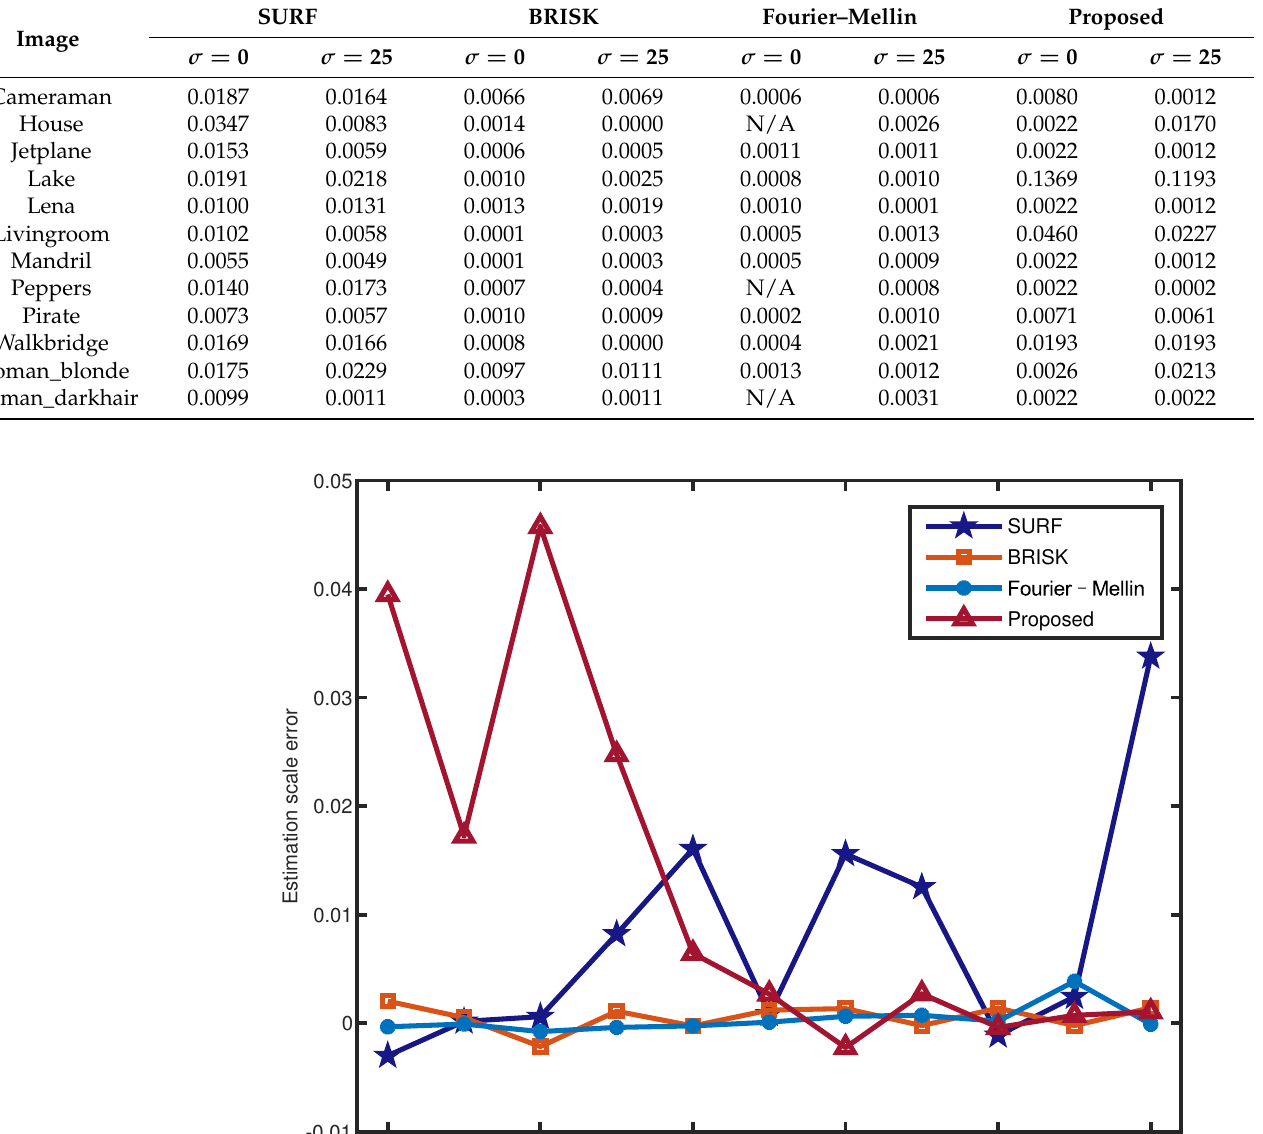
Table 3. Comparison of fixed scale estimation errors (the fixed rotation angle is 60 ◦ and scale is 0.8).